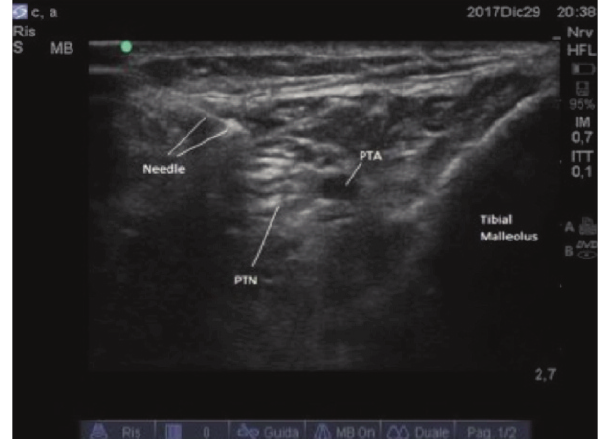
Ultrasound guided posterior tibialis nerve block. (LIA: Fig. 2: Local Infiltration Anaesthesia; PTNB: Posterior Tibialis Nerve Block).